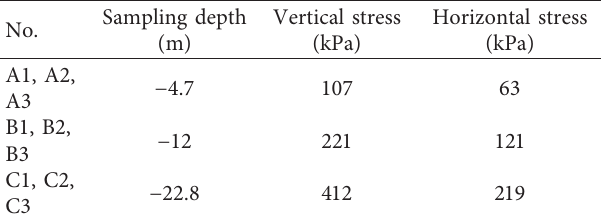
Figure 7: The schematic diagram for the soil stress path during foundation pit excavation. Table 2: Natural stress levels of the samples.